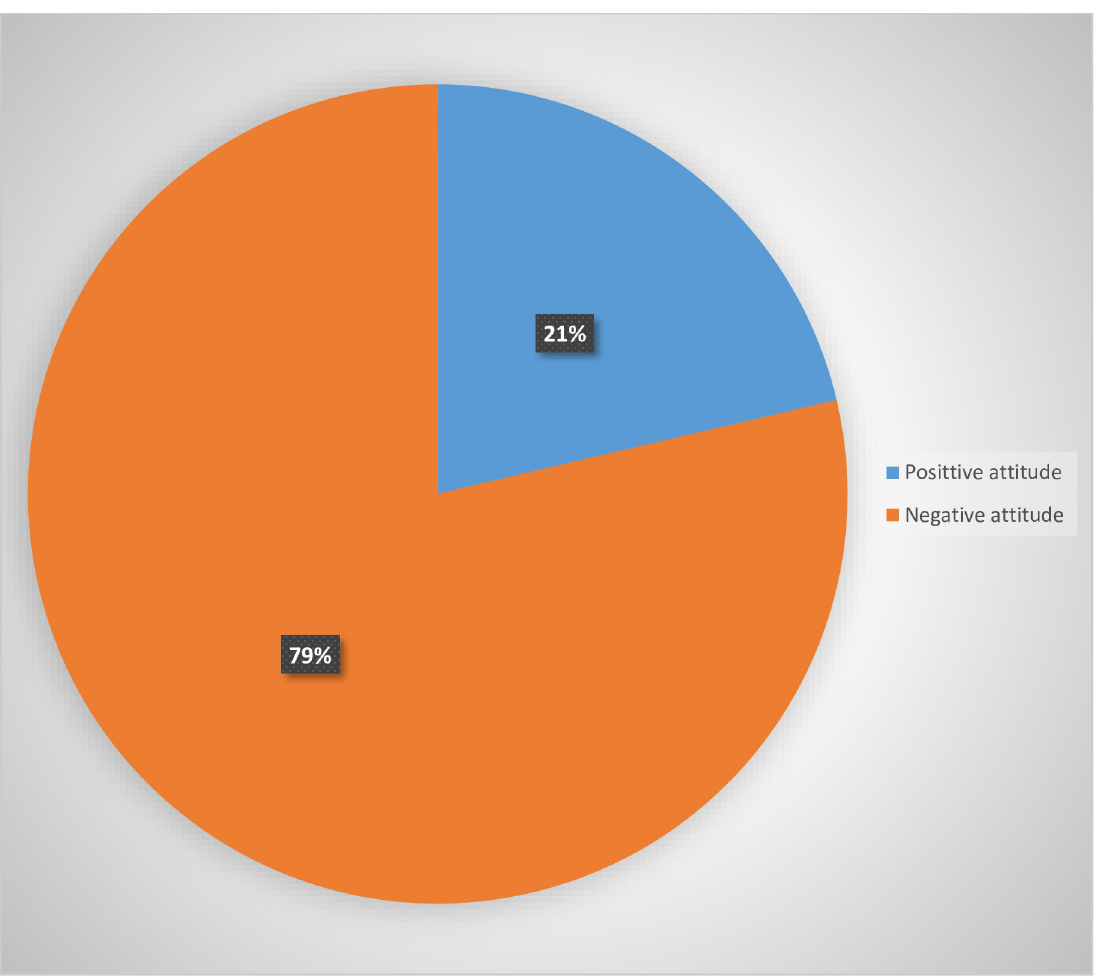
Fig 2. Attitude towards preconception care among reproductive age women in Miza Aman town, Bench-Sheko Zone, Southwest Ethiopia, 2020 (n =